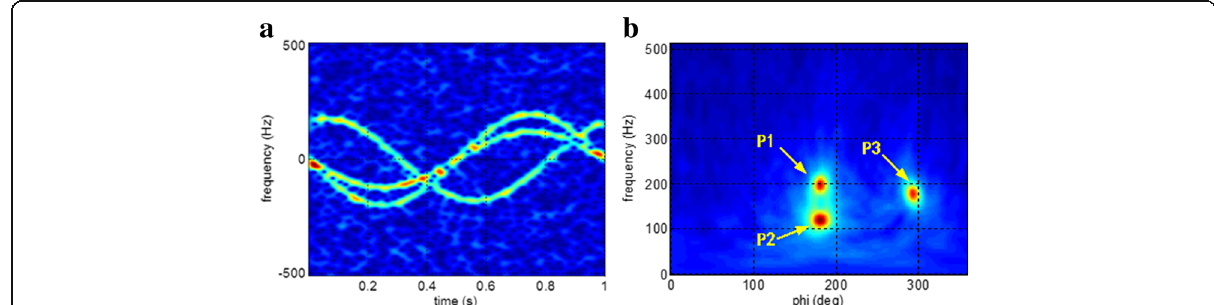
Fig. 6 Results of experiment No. 1. (carrier frequency: 40 GHz, SNR: 3 dB, scattering centers: P1, P2, and P3). a The time-frequency image. b The parameter space